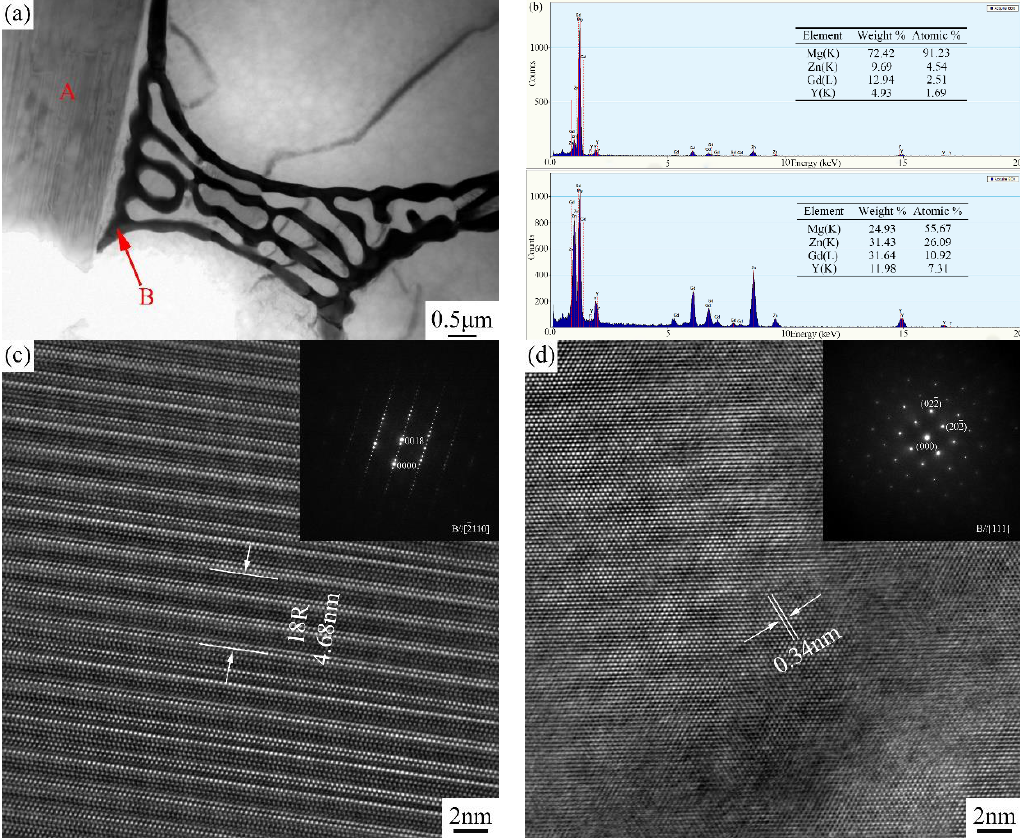
Figure 14. TEM observations and correspond EDS results, HRTEM images and selected area electron diffraction (SAED) patterns of the phases in Mg–7Gd–5Y–5Zn–0.5Zr alloy: ( a ) bright field (BF) image obtained from the alloy, ( b ) is the corresponding EDS results of the regions marked A and B, ( c ) and ( d ) are HRTEM images and corresponding SAED patterns of the phases.